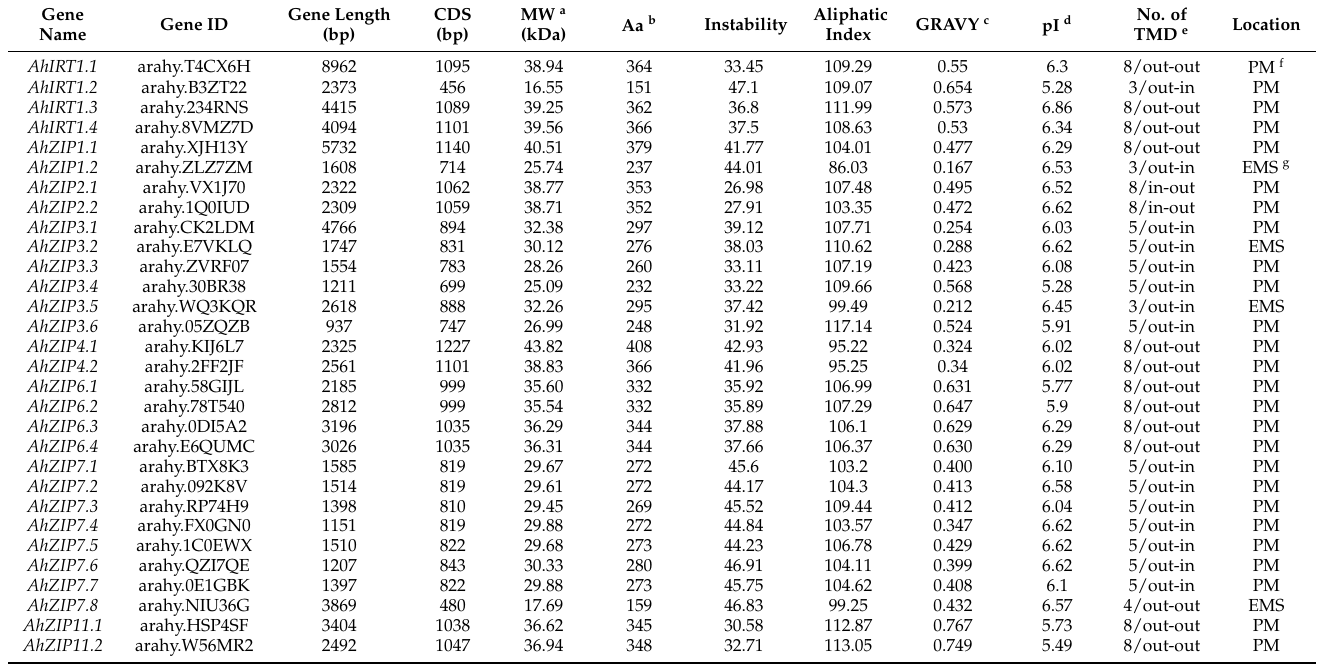
Table 1. Molecular characterization of AhZIP genes identified in